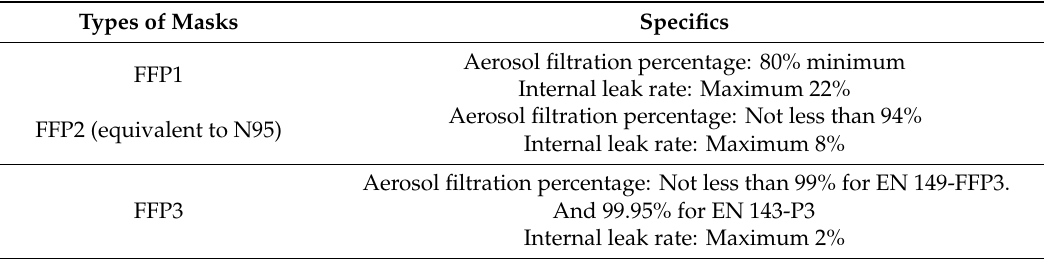
Table 2. Aerosol filtration percentage and internal leak rate for FFP